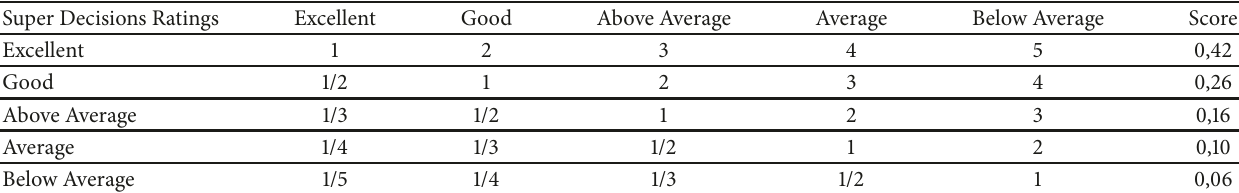
Table 3: Five intensity levels and their corresponding